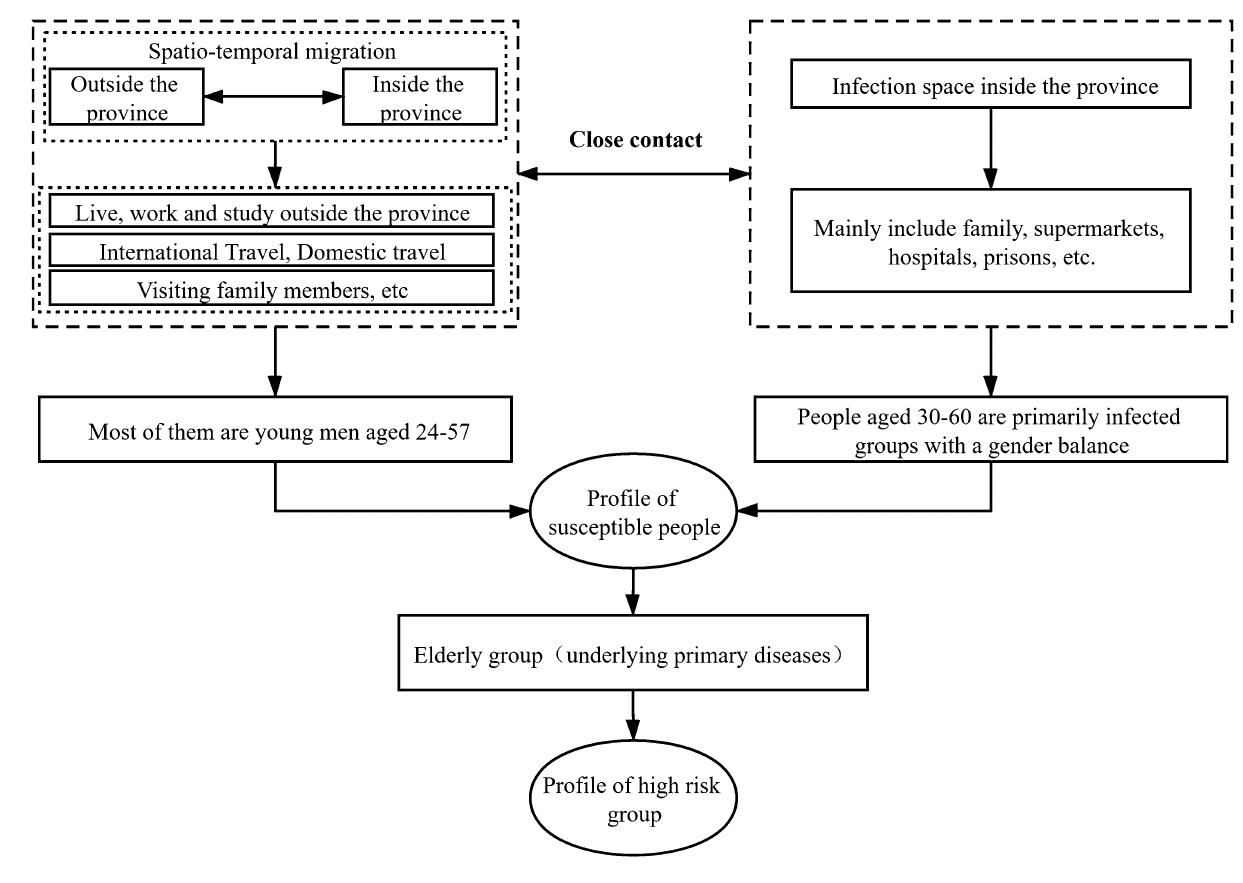
Figure 6. Profiling susceptible and high-risk groups of COVID-19 in Shandong province.